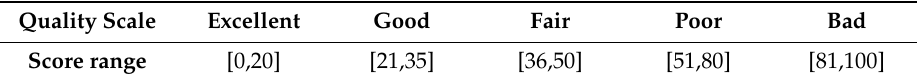
Table 4. PIQE assessment range [23].